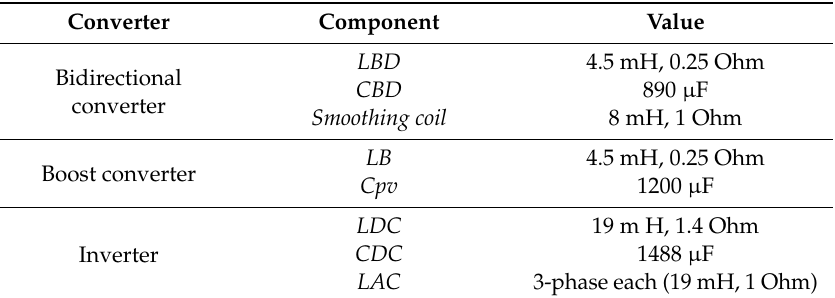
Table 2. Inductances and Capacitance of the Converters of the DC microgrid